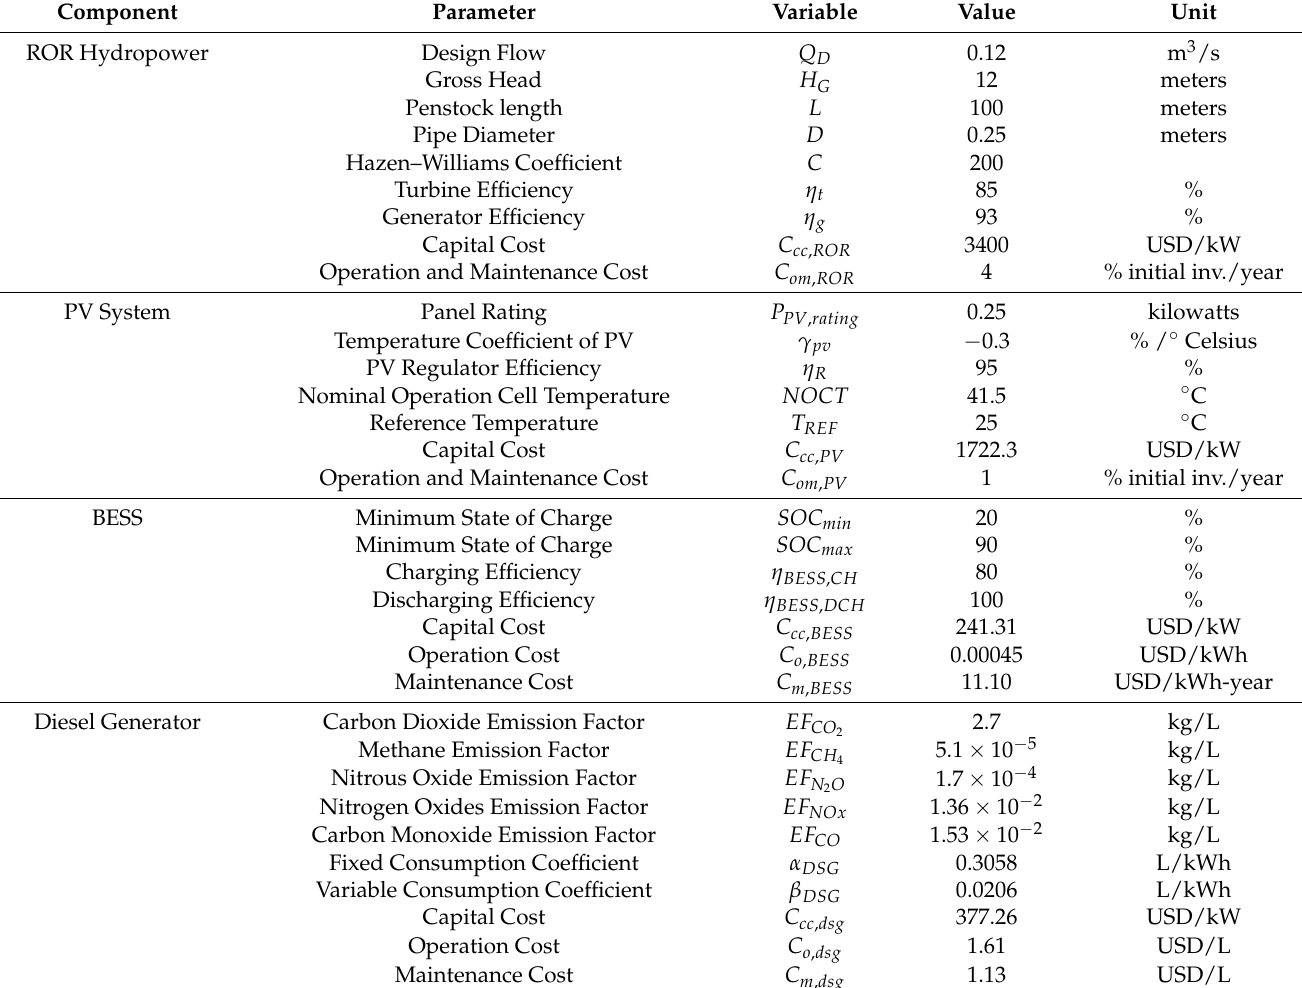
Table 4. HREM component financial and technical